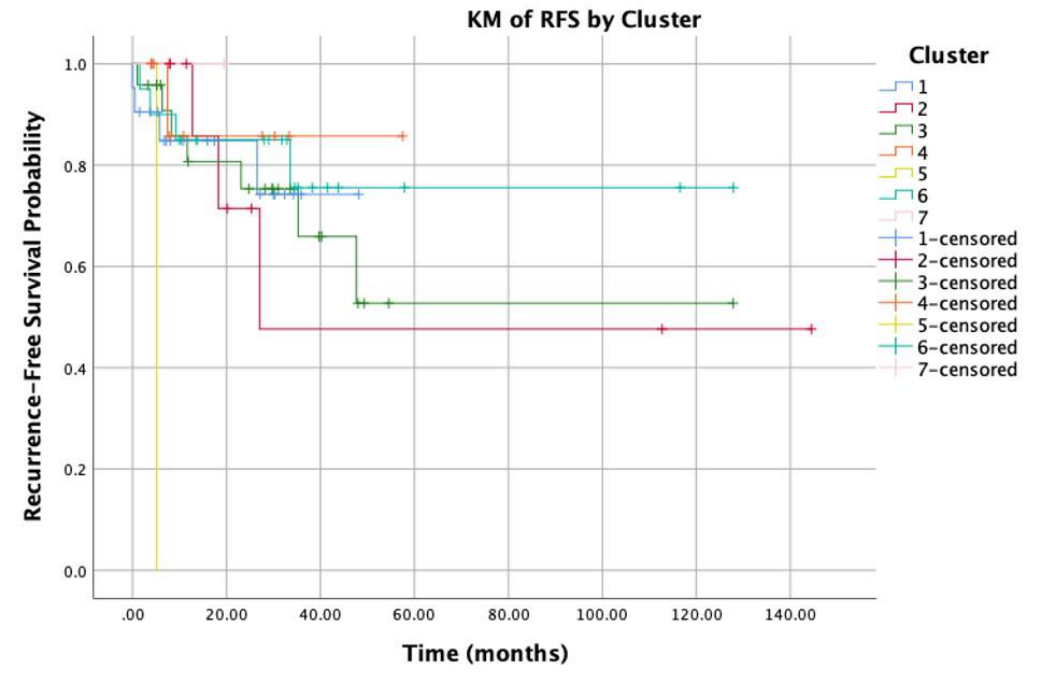
Figure 3. Kaplan-Meier analysis for recurrence free survival of patients.